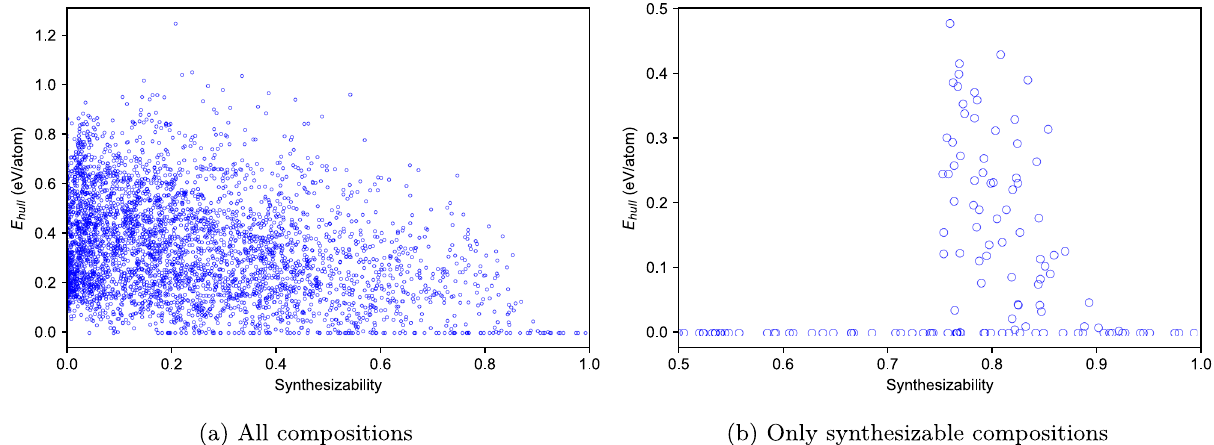
Fig. 7 Half-Heusler synthesizability predictions for unreported ABC compositions. Predicted half-Heusler synthesizabilities with calculated E hull values for ( a ) 4141 ABC compositions thatare unreported in the ICSD, Springer Materials, and ASM, and ( b ) thesubset thatissynthesizable. Compositionsaregenerated by combinatorially combining sets of A, B, and C elements found in reported half-Heuslers. Compositions are considered synthesizable when predicted synthesizabilities > 0.5 if stable and >0.75 if unstable. As expected from the combinatorial composition generation, a majority are predicted unsynthesizable.